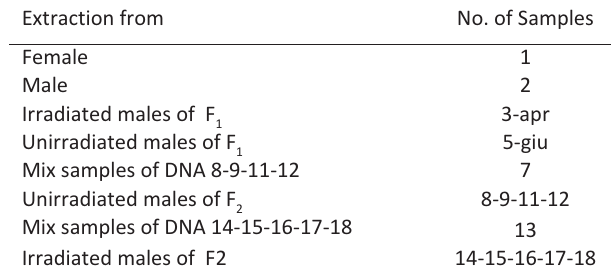
Table 3 - F progressed studied families and the families of F 1